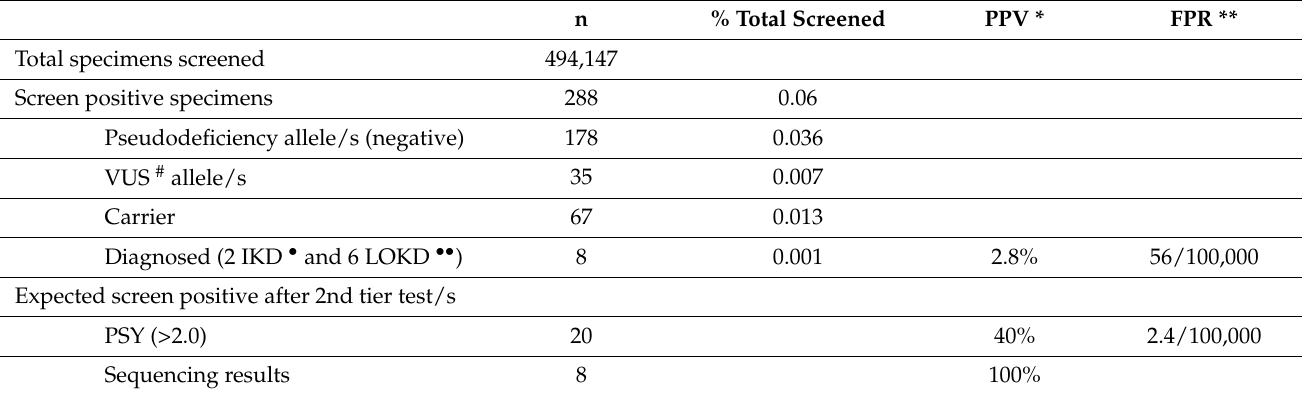
Table 4. Results from 2 years of full population newborn dried blood spot screening for KD in